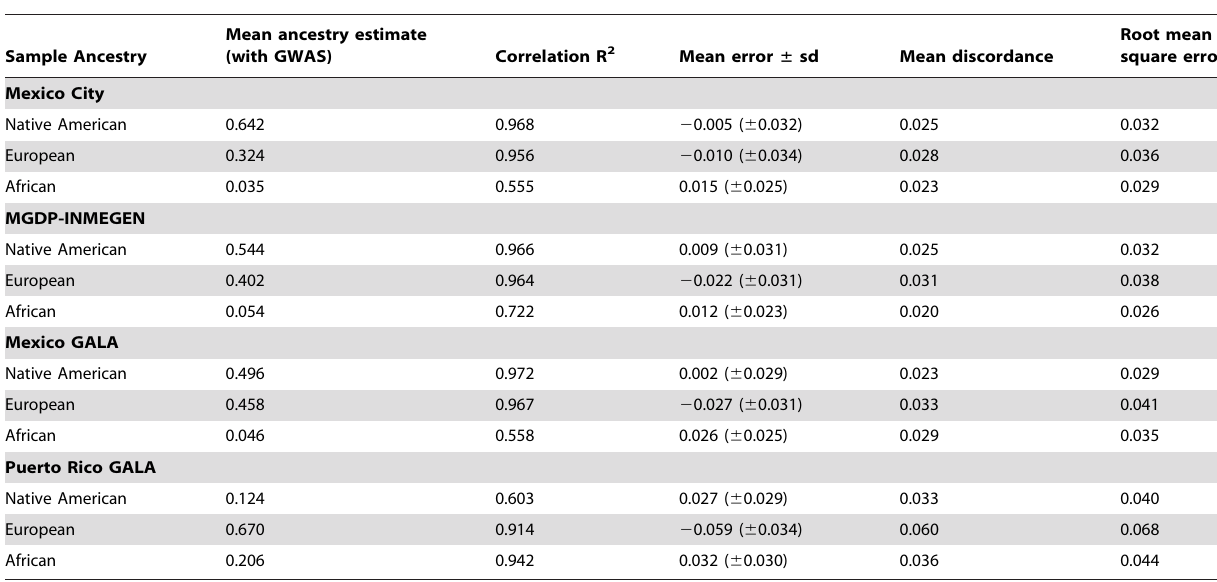
Table 2. Validation of the AIMs panel compared to ancestry estimates using GWAS